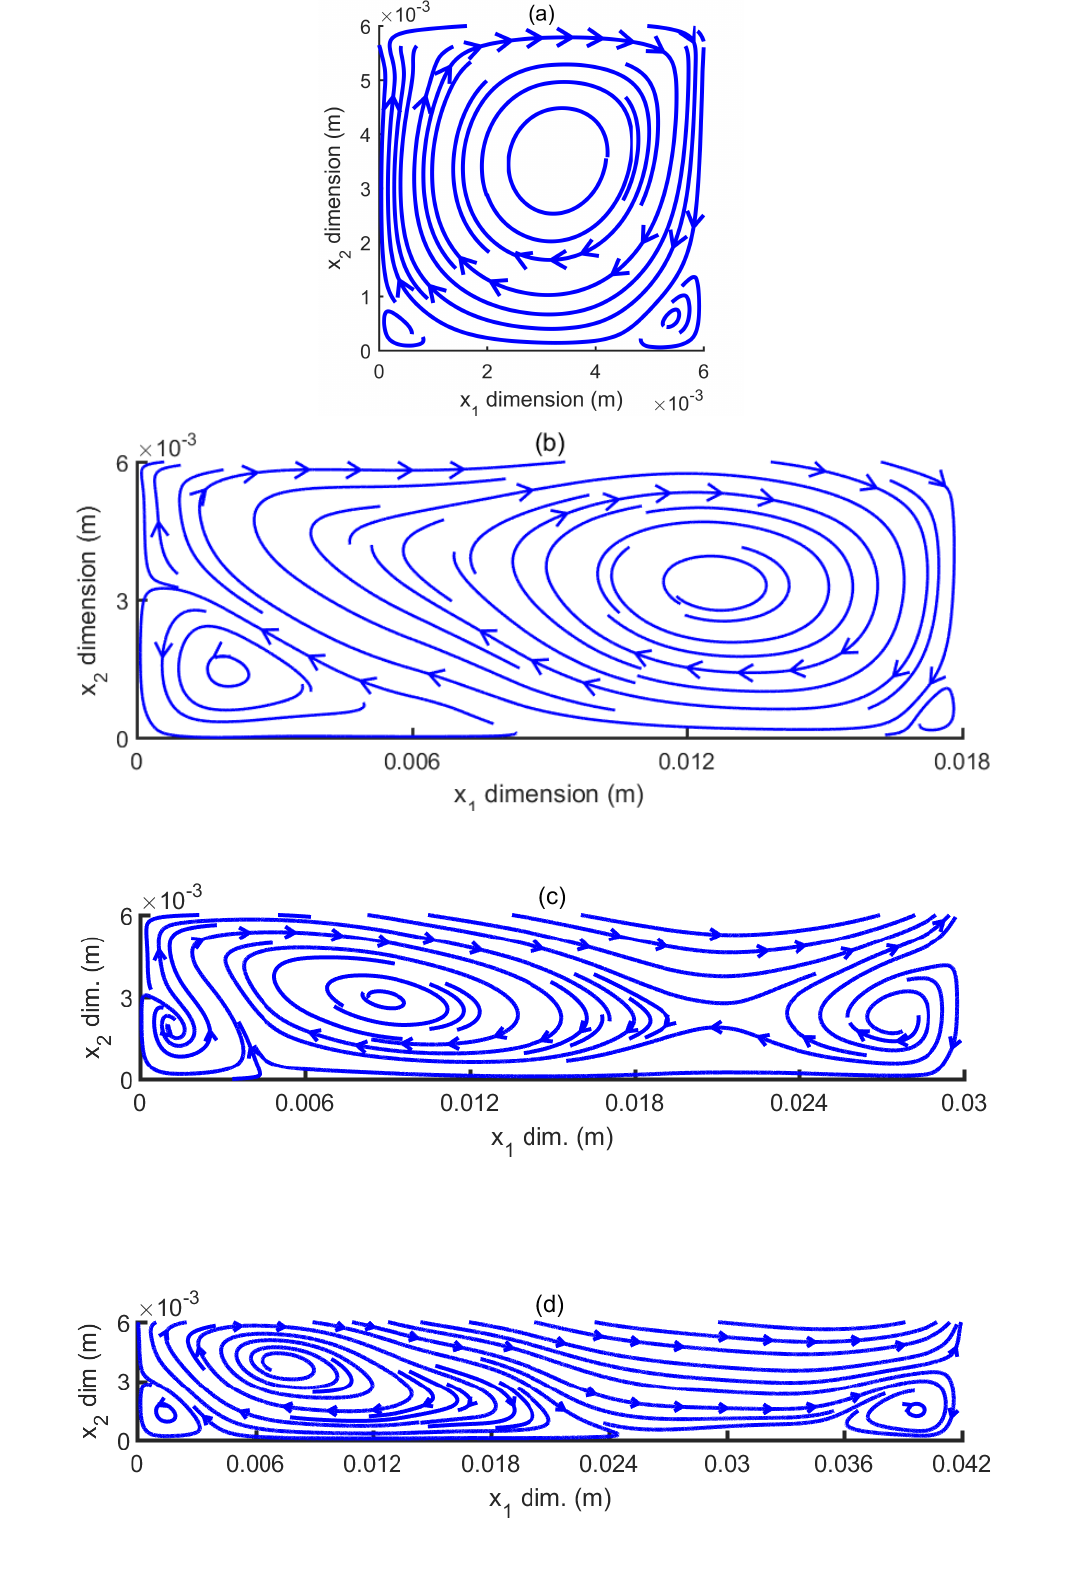
Figure 18. Vertical planes (at x 3 = 0.0375 m) showing streamlines of the mean flow in the cavity between two adjacent bars for: ( a ) Run 1 ( λ / k = 2); ( b ) Run 2 ( λ / k = 4); ( c ) Run 3 ( λ / k = 6; and ( d ) Run 4 ( λ / k =